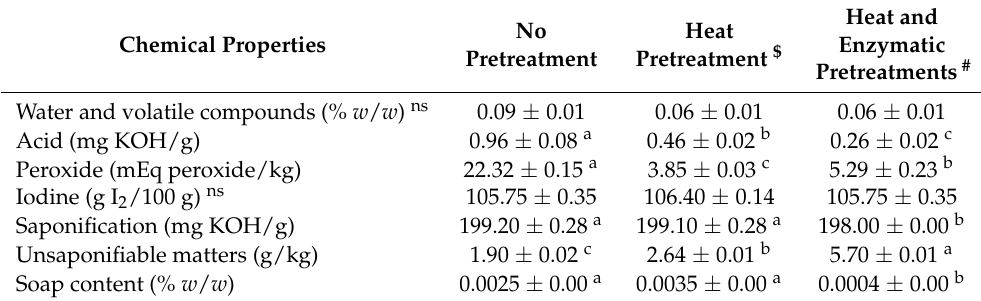
Table 5. Chemical properties of H. heteroclita seed oils under different mechanical extraction pretreat- ment